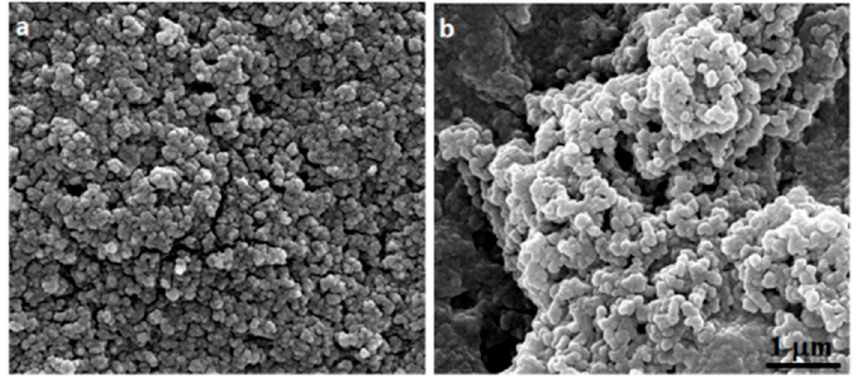
Figure 2. SEM images of empty chitosan NPs ( a ) and carvacrol-loaded nanoparticles ( b ).